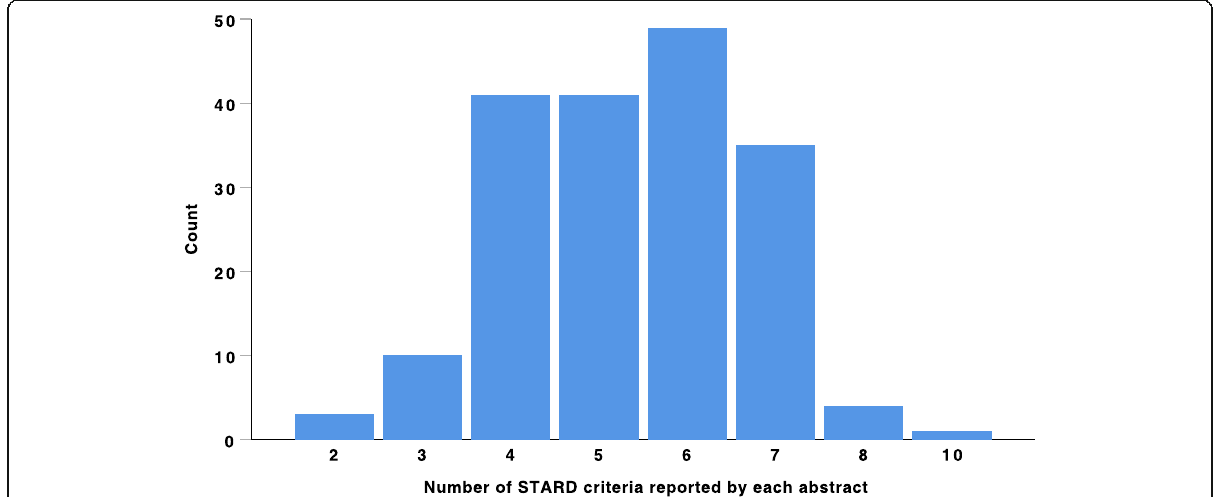
Fig. 1 Histogram showing the number of STARD criteria reported by each abstract